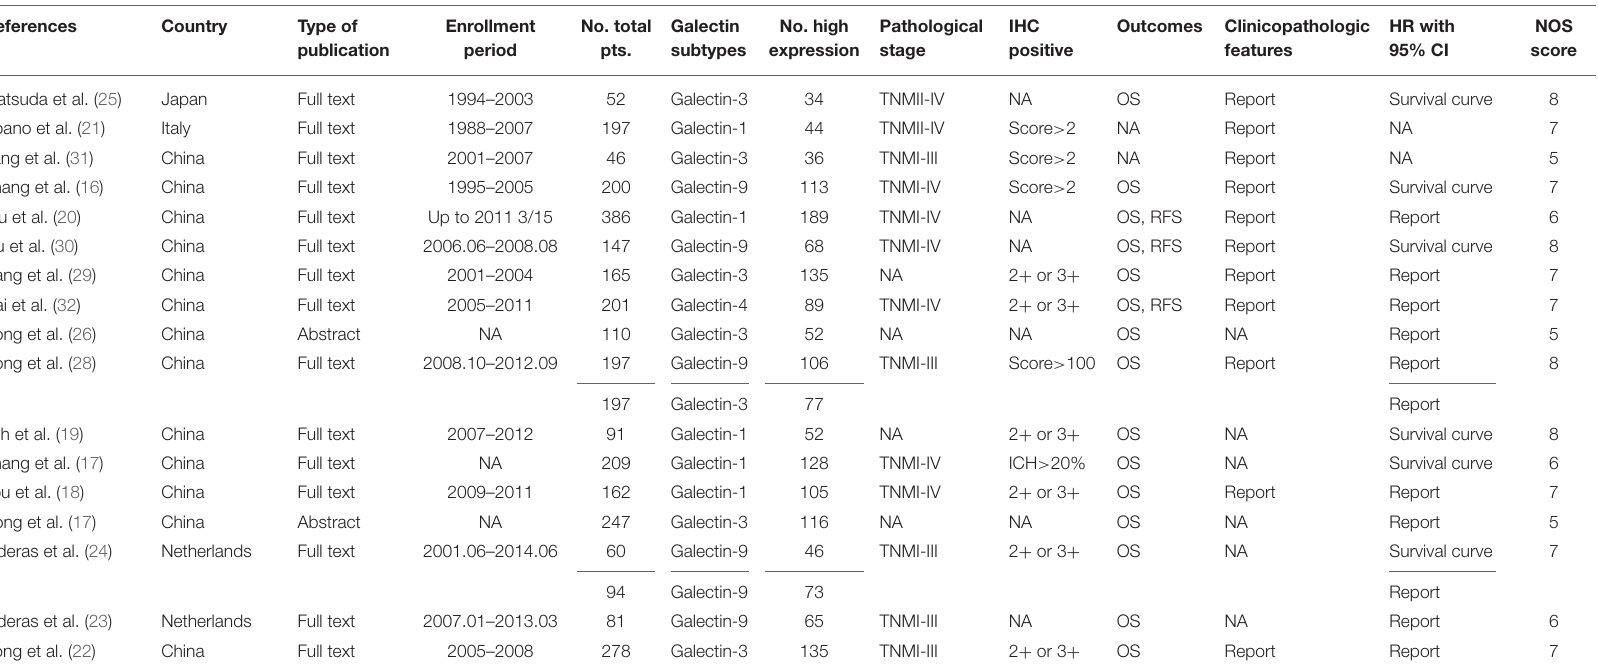
TABLE 1 | Characteristics of the included studies regarding the galectins with the prognosis and clinicopathological features of HCC in the